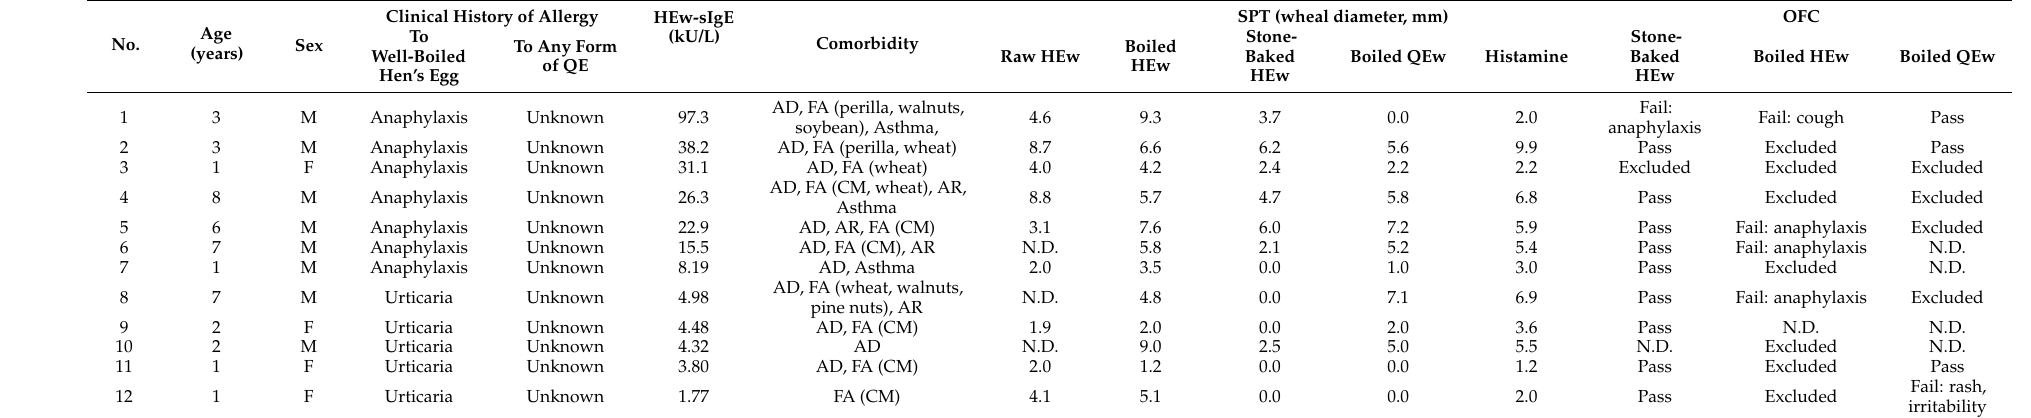
Table 1. Clinical and immunological characteristics of